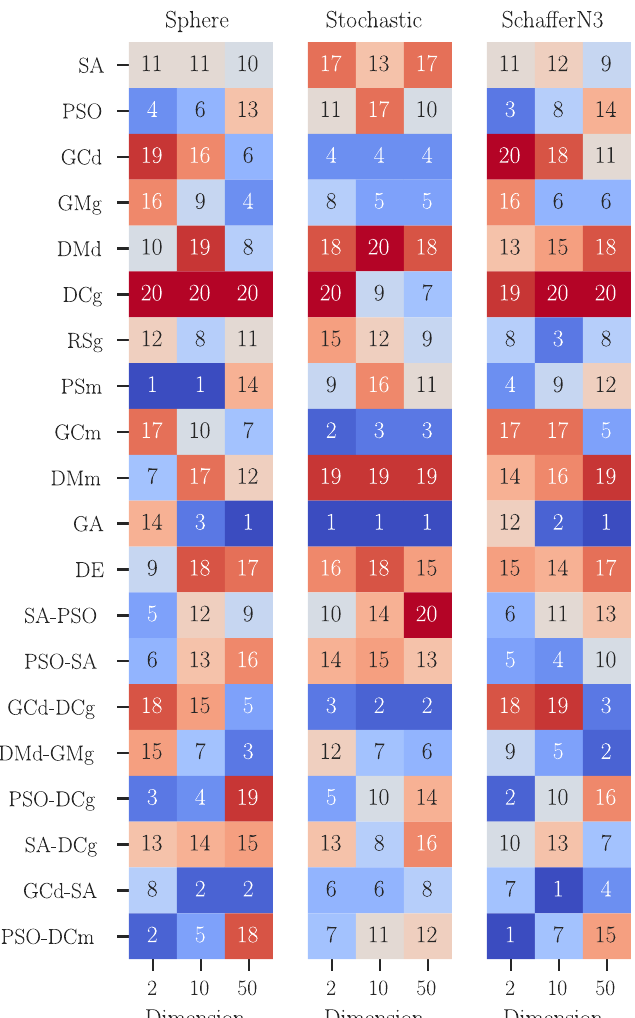
Figure 5. Rank of the metaheuristics based on the median and interquartile range of the fitness values obtained when solving Sphere, Stochastic, and Schaffer N3, both for 2, 10, and 50